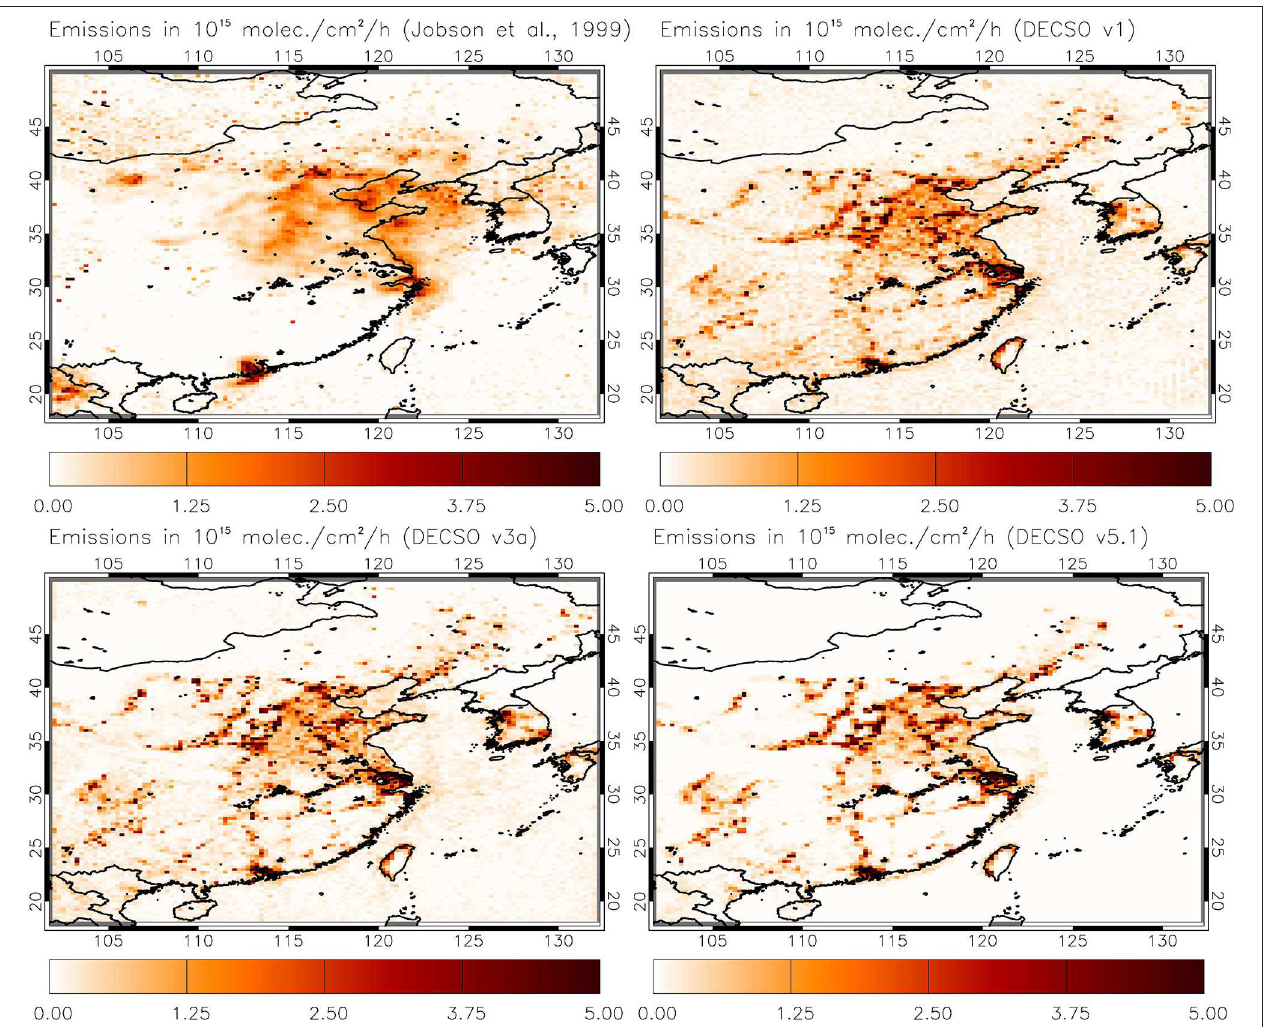
FIGURE 2 | Emission estimates for 2007 from lifetime ( τ ) calculations from OMI daily data after Jobson et al. (1999) (see text), where τ = (1/ σ {ln[NO 2 ]}) (1 / 0.18) (upper left) compared with DECSO v1 NOx emissions (upper right), DECSO v3a NOx emissions (lower left) and DECSO v5.1 NOx emissions (lower right). The map axes are in degrees Eastern longitude/Northern